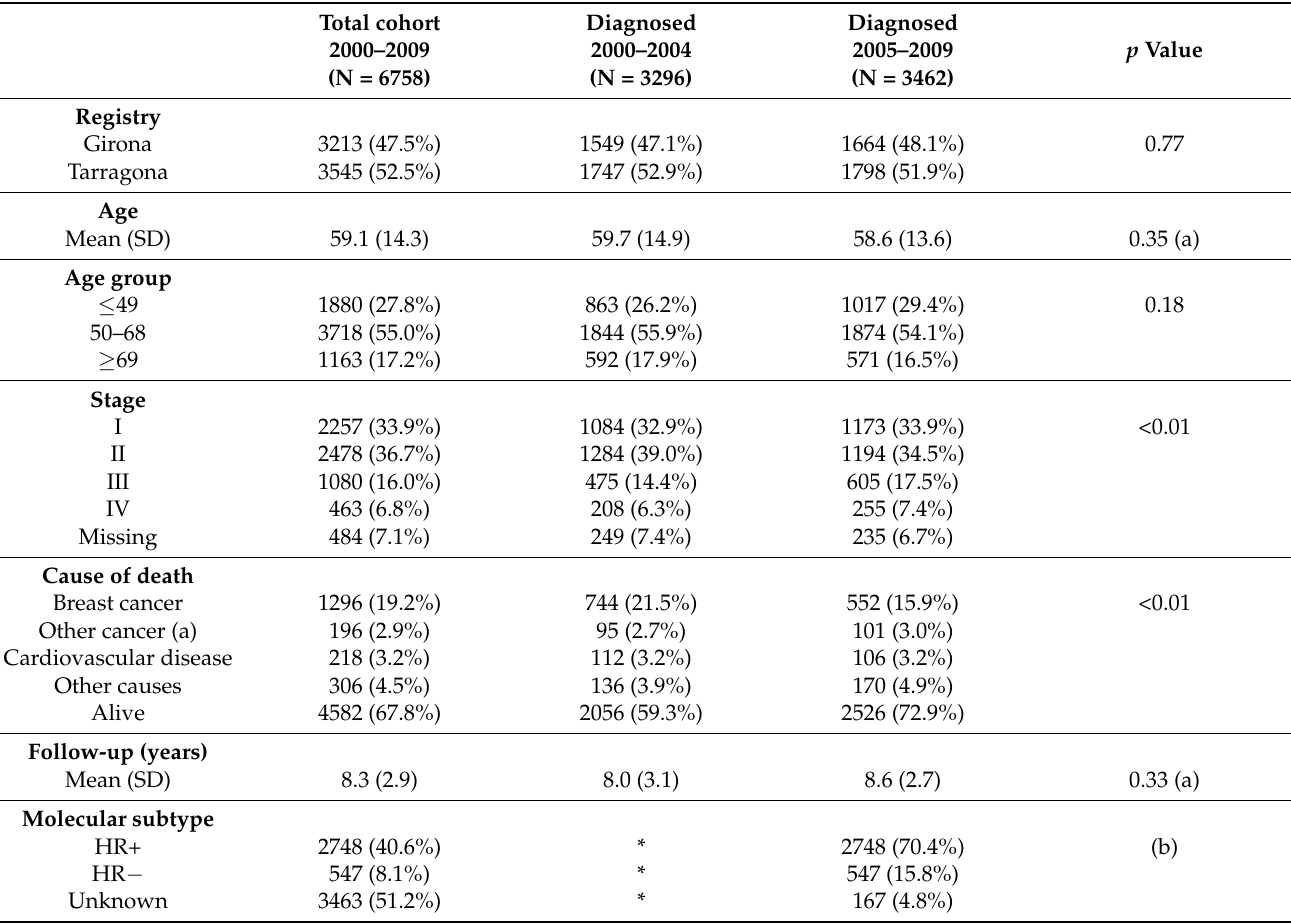
Table 1. Characteristics of patients diagnosed with breast cancer from 2000 to 2009 in Girona and Tarragona.